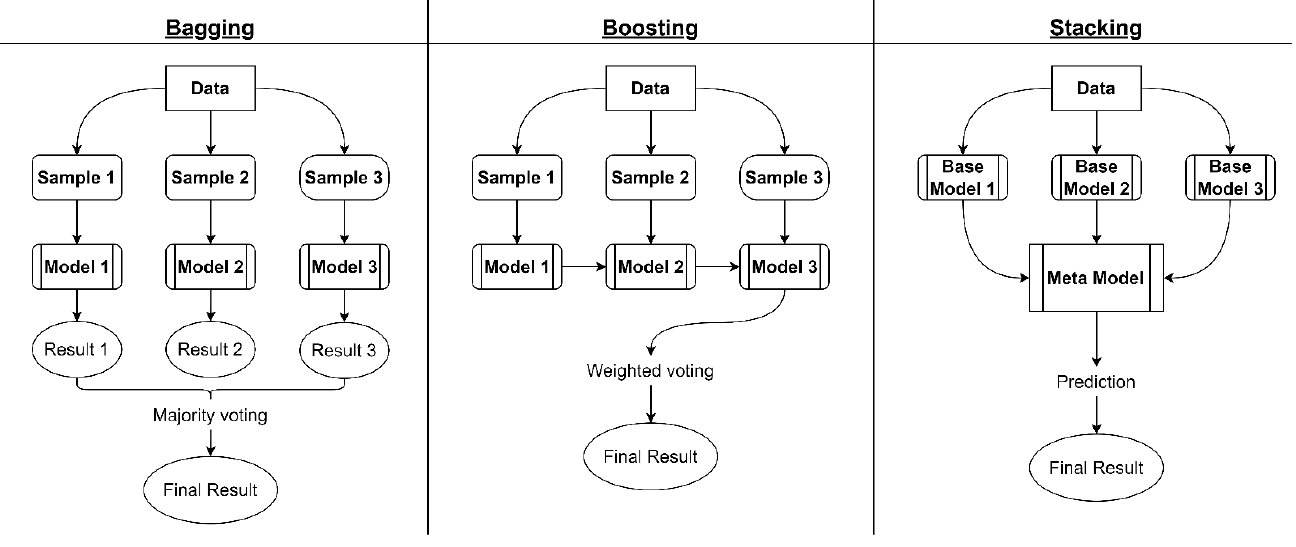
Figure 1. Three main classes of ensemble methods.